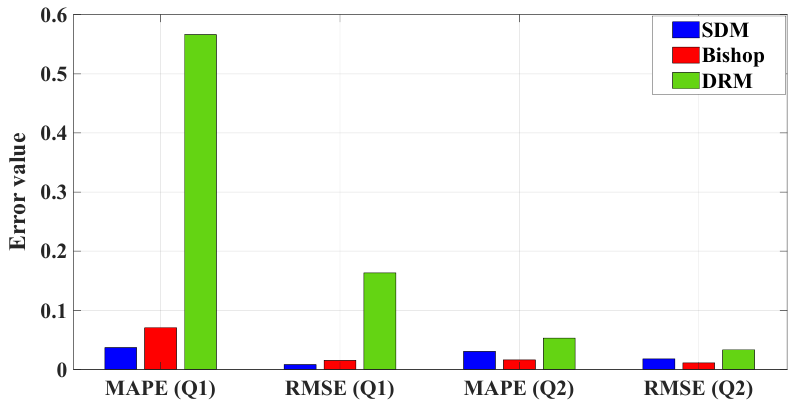
Figure 10. Estimation error for each